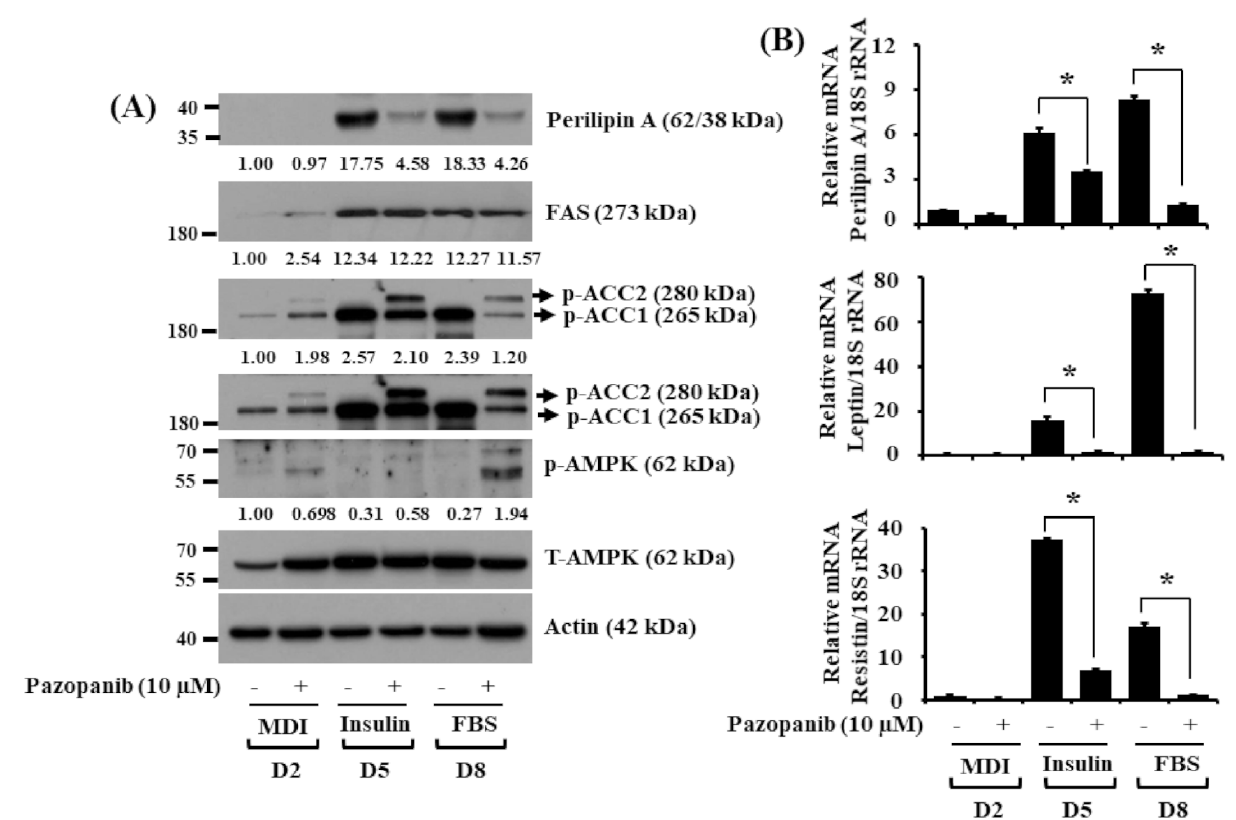
Figure 3. Effects of pazopanib on expression and phosphorylation levels of perilipin A, FAS, ACC, AMPK, leptin, and resistin during 3T3-L1 preadipocyte differentiation. ( A ) 3T3-L1 preadipocytes were differentiated with induction medium containing MDI, insulin, and FBS in the absence (control; 0.1% DMSO) or presence of pazopanib (10 µ M), and harvested at day 2 (D2), D5, and D8, respectively. At each time point, whole-cell lysates were prepared and analyzed by immunoblot analysis with respective antibodies. p-ACC, phosphorylated ACC; T-ACC, total ACC; p-AMPK, phosphorylated AMPK; T-AMPK, total AMPK. ( B ) 3T3-L1 preadipocytes were differentiated with induction medium containing MDI, insulin, and FBS in the absence or presence of pazopanib (10 µ M), and harvested at D2, D5, and D8, respectively. At each time point, total cellular RNA was extracted and analyzed by real-time qPCR with respective primers. mRNA levels of perilipin A, leptin, and resistin were normalized to those of control 18S rRNA. Data are mean ± SE of three independent experiments, each done in duplication. * p < 0.05 vs.